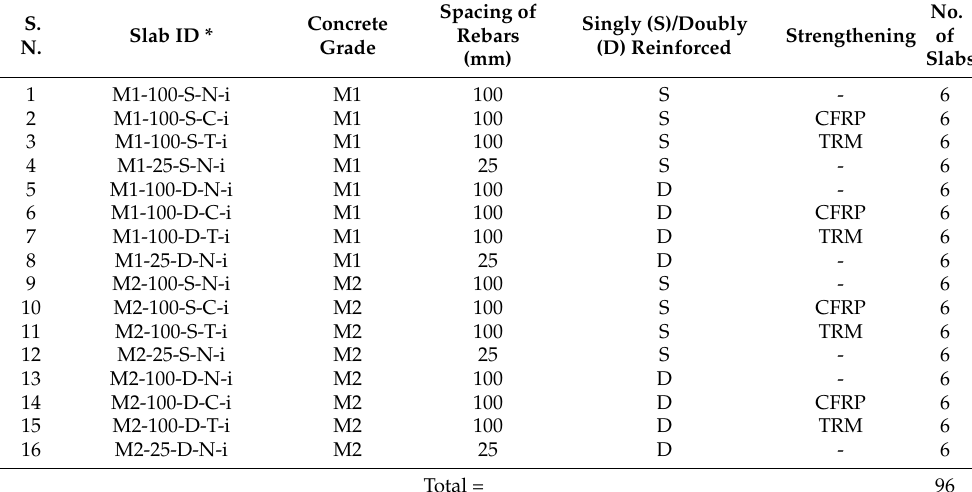
Table 1. Experimental